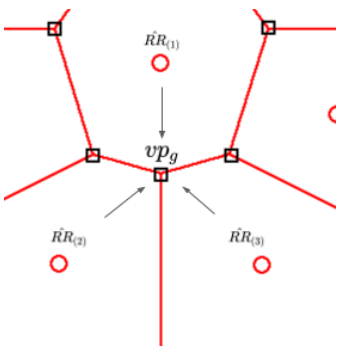
Figure 3. Vertex and colliding